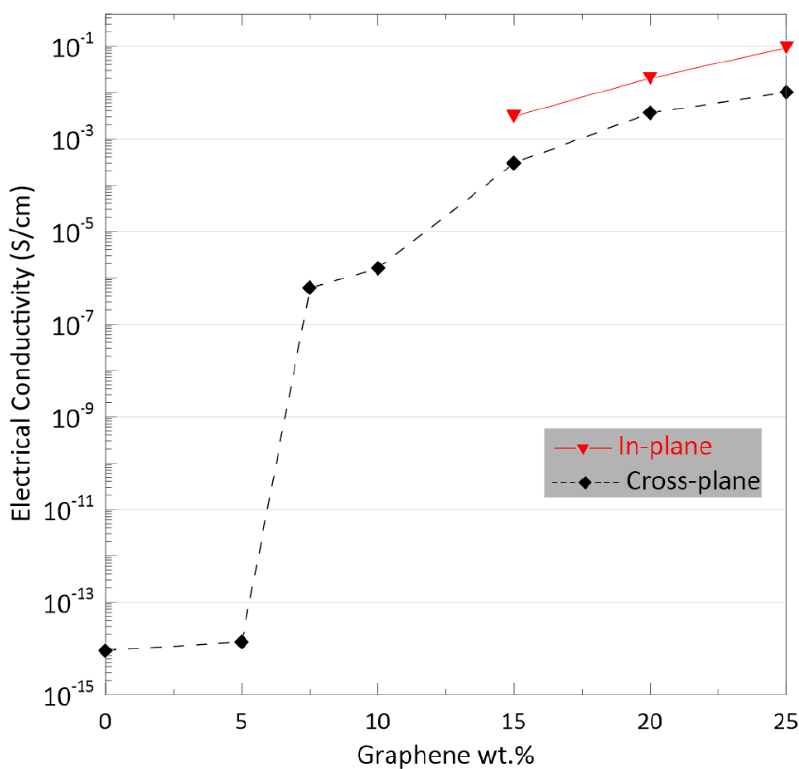
Figure 1. Electrical conductivity versus the GnP content for the Gr3x/polyester composites.